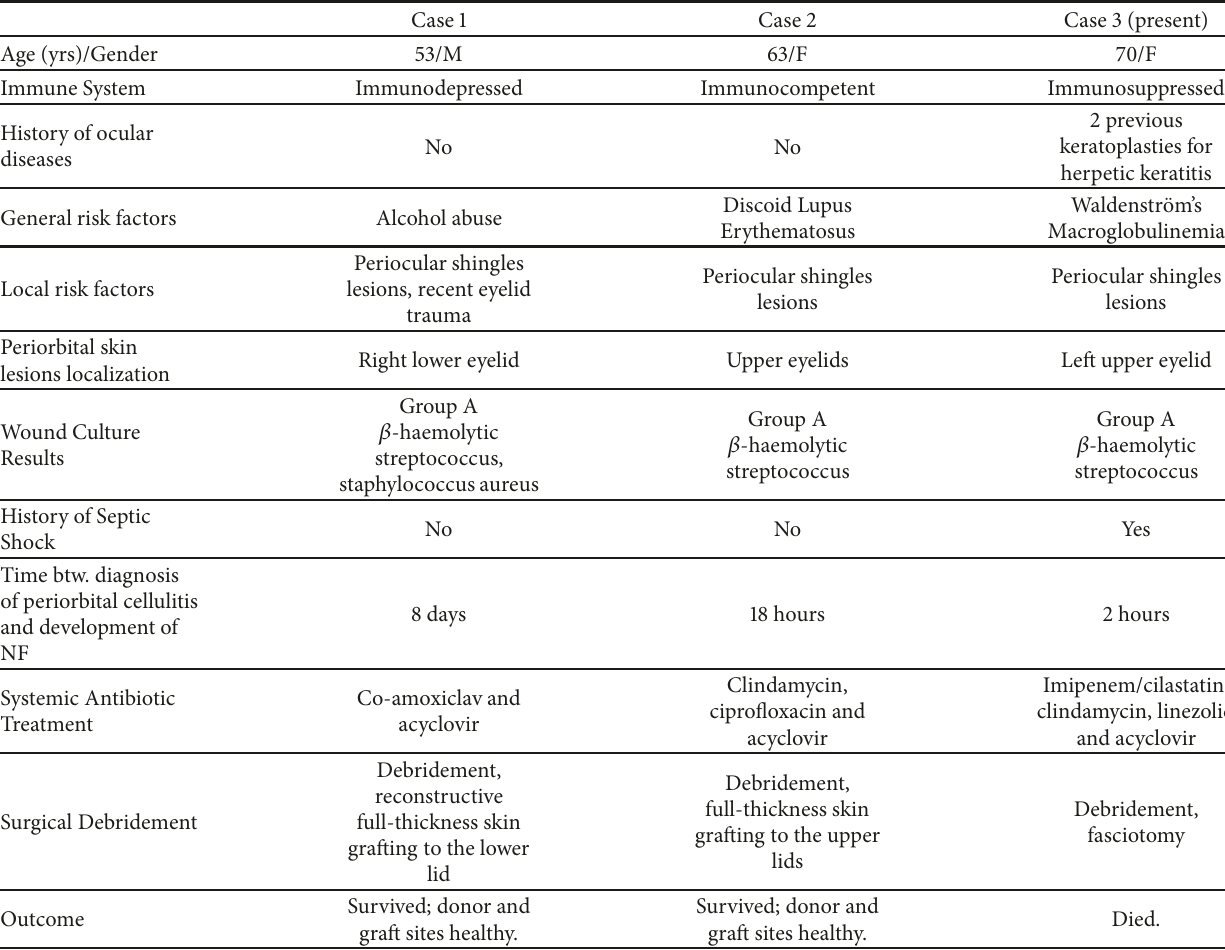
Table 1: Comparison between three cases of periorbital NF following cutaneous herpes